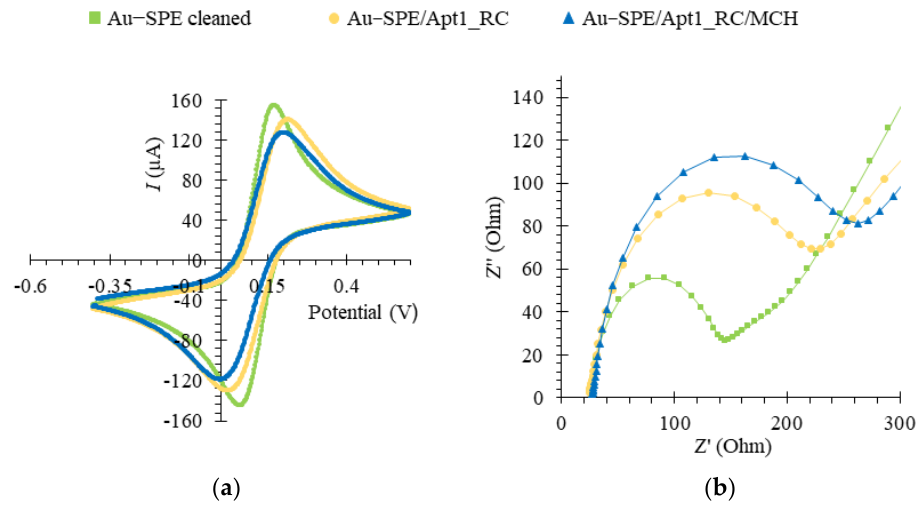
Figure 6. Electrochemical assays to assess the assembly of the aptasensor upon functionalization of the Au-SPE surface, in 5.0 × 10 −3 M [Fe (CN) 6 ] 3− and 5.0 × 10 −3 M [Fe (CN) 6 ] 4− solution, prepared in phosphate buffer, pH 7.4. Cyclic voltammetry (CV) ( a ) and electrochemical impedance spectroscopy (EIS) represented by a Nyquist plot ( b ).